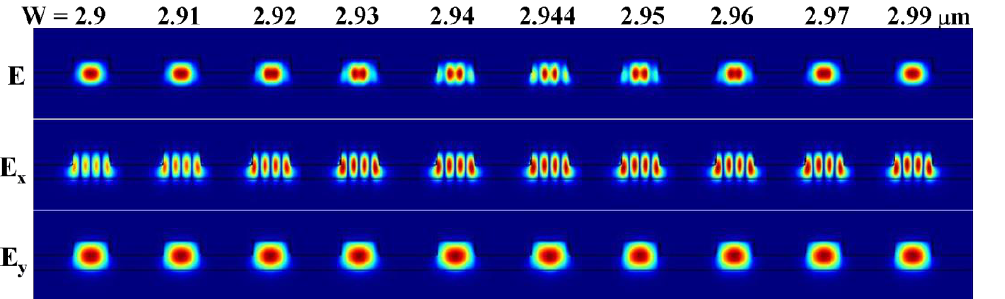
Figure 9. Evolution of two-dimensional distributions of electric field E and its two components E x and E y of the TE 00 mode of the 980 nm pump wave with the rib width W in the range from 2.9 to 2.99 µm in the case of rib height h = 0.5 µm.